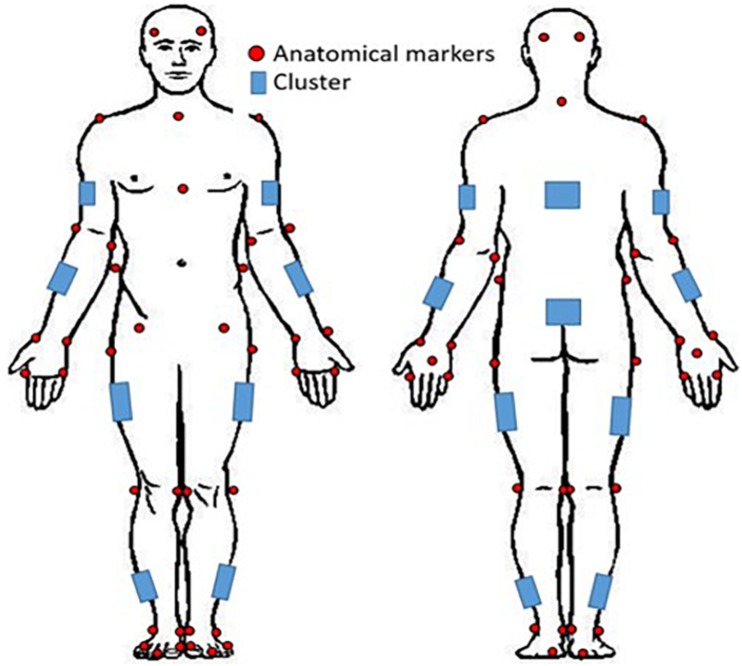
Whole-body reflective marker set up. Marker clusters were placed bilaterally on the shank, thigh, forearm, and upper arm as well as on the pelvis and trunk. Anatomical markers were placed on the anterior and posterior lateral aspects of the head, suprasternal notch, xiphoid process, 7th cervical vertebra; and bilaterally on the acromion, lateral and medial epicondyles, radial and ulnar styloid processes, 2nd and 5th metacarpals, dorsum of the hand, iliac crest, anterior superior iliac spine, greater trochanter of femur, lateral and medial condyles, lateral and medial malleoli, 1st and 5th metatarsal, dorsal tarsal midline, and calcaneus.